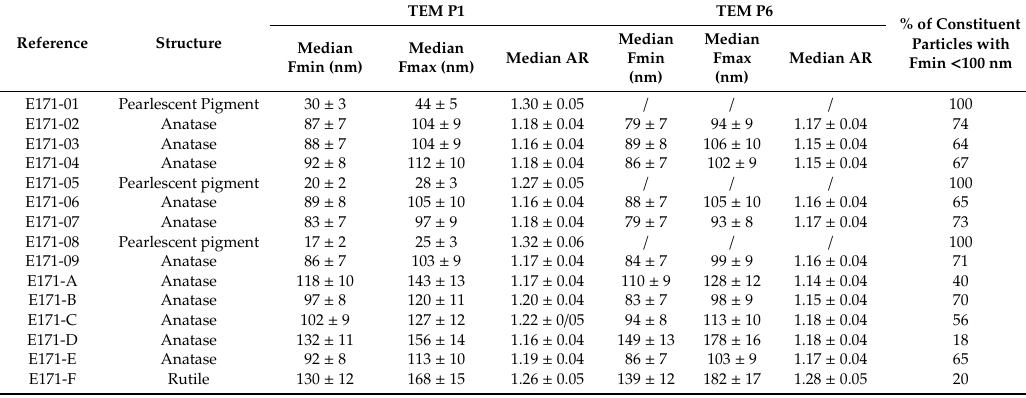
Table 6. Analysis results of the 15 E171 materials, including structure and median values of the Fmin, Fmax, and AR distributions obtained by quantitative TEM for samples prepared by protocols P1 and P6. The expanded measurement uncertainties (Ucx, k = 2) are estimated based on the validation study of Verleysen et al. [59] for representative test materials NM-100 and NM-103. The % of constituent particles with Fmin < 100 nm, obtained by P1 for pearlescent pigments and by P6 for anatase E171 materials and E171-F, are